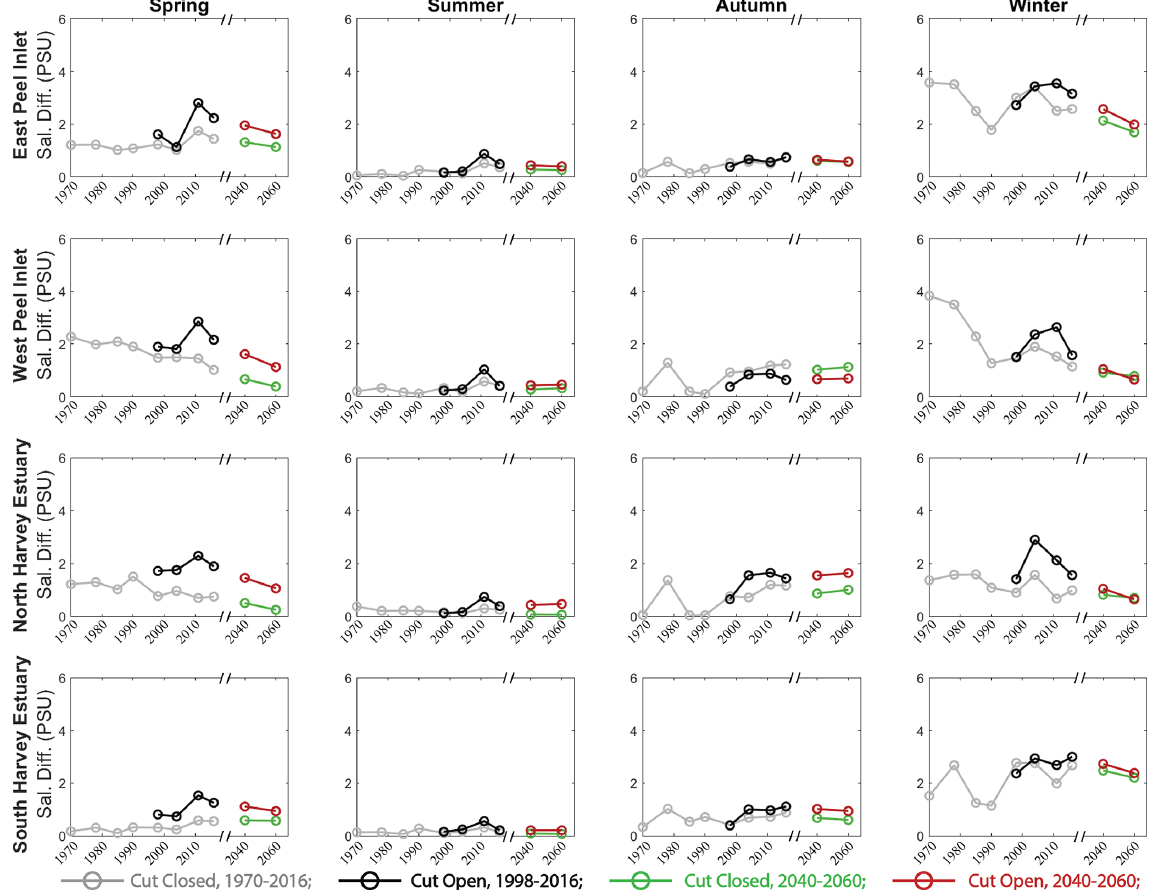
Figure 12. Changes of mean salinity difference between surface and bottom waters in PHE in the simulated years and future scenarios. As for Fig. 8, the changes are categorized into four zones and four